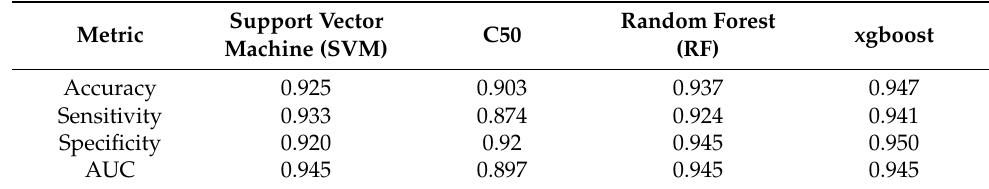
Table 5. Final features list for building the prediction model.